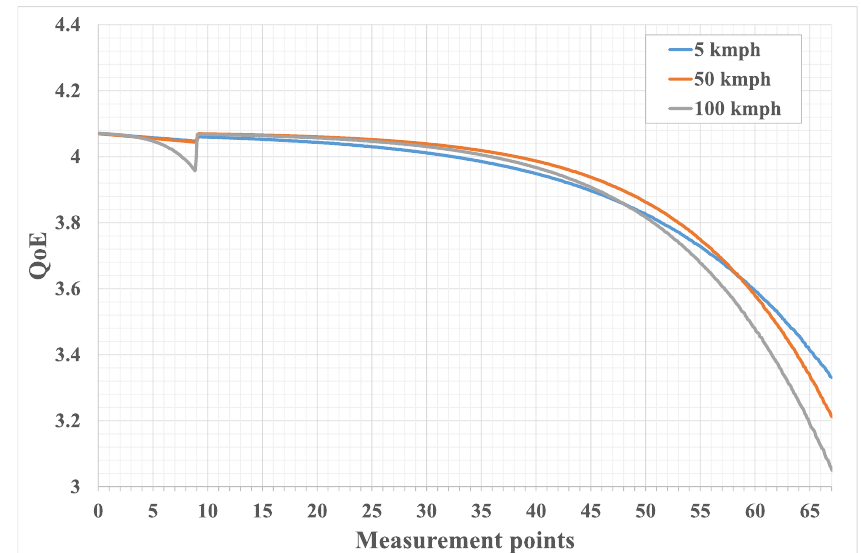
Figure 10. Calculation of QoE by (7) for different UE